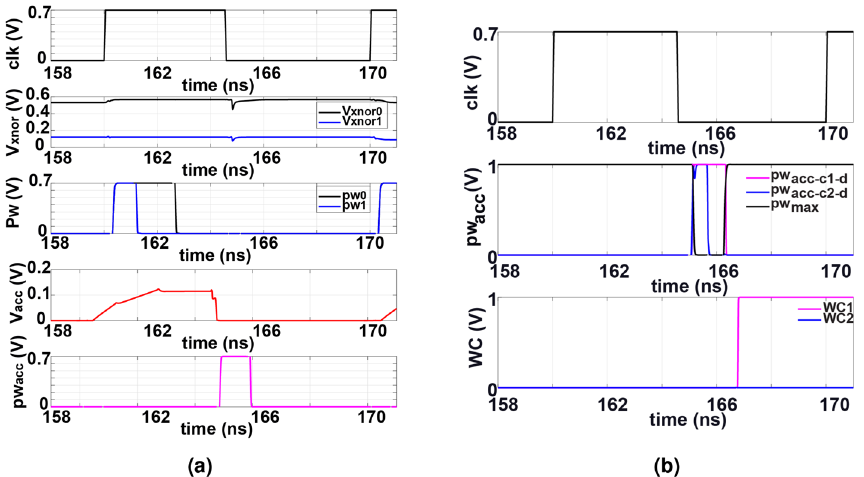
Figure 5. ( a ) Output waveform of the proposed block using 32-bit XNOR-based RRAM divided into two 16-bit XNOR RRAM. Each 16-bit XNOR RRAM is followed by VTC, TVC and TVC. One 16-bit XNOR RRAM with 3 matching-inputs cells and the second is with 16 matching-inputs cells. ( b ) Output waveforms of the proposed WCL block. It shows that pw acc − c 1 − d has a wider pulse width compared to pw acc − c 2 − d . As a consequence, it is determined as the winning class with WC1 = 1 V and WC2 = 0